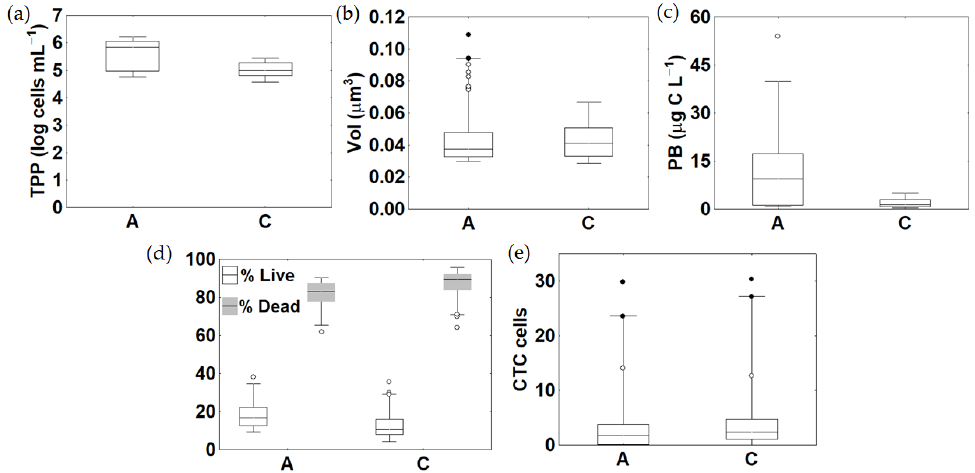
Figure 5. Box plots of microbial parameters studied by Image analysis: ( a ) Total prokaryotic abundance (TPP), ( b ) cell volumes (VOL) ( c ) prokaryotic biomass (PB), ( d ) percentages of the living and dead cells and ( e ) respiring cells (CTC+). The boxes are characterized by a median line and boundaries indicating 25th and 75th percentiles; whiskers are characterized by a vertical line indicating 5th and 95th percentiles. White dots = outliers, black dots = extreme